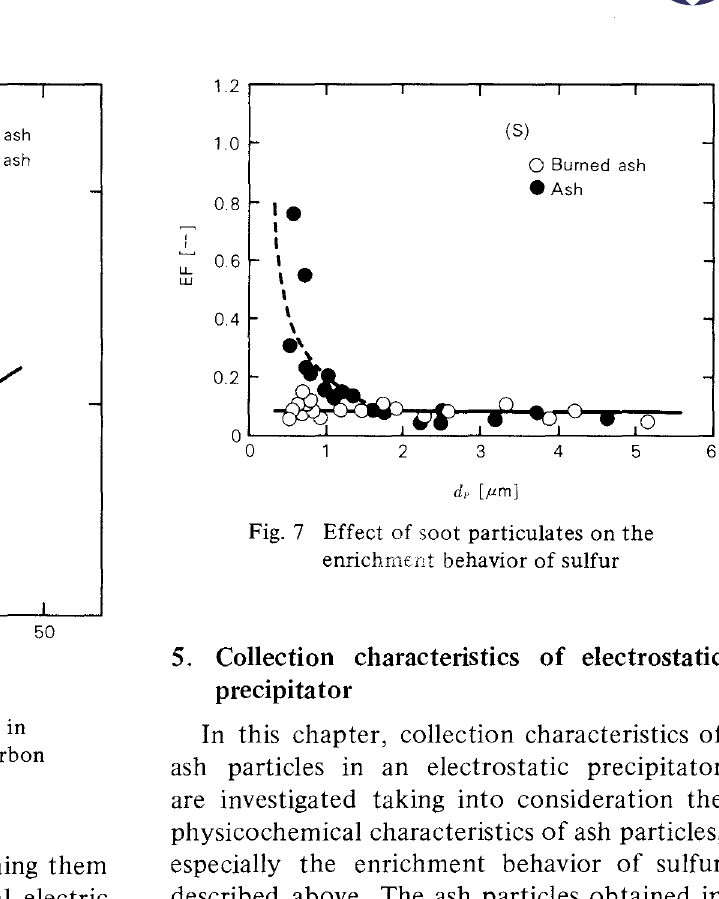
Fig. 7 Effect of soot particulates on the enrichment behavior of sulfur